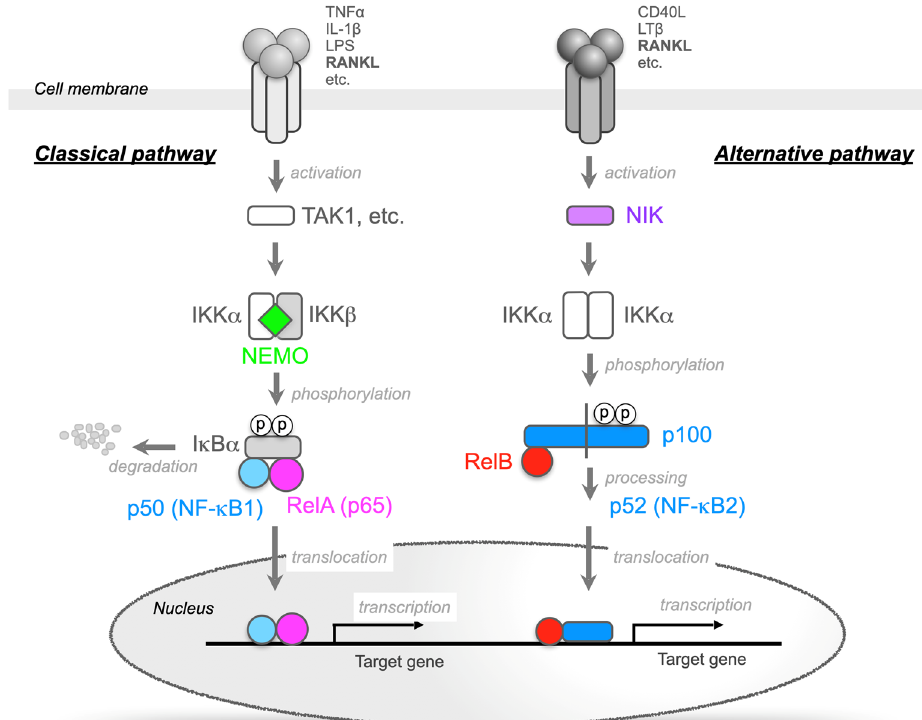
Figure 2. Two different NF- κ B signaling pathways. The classic (canonical) pathway ( left ) is activated by a large number of agonists, such as TNF- α , IL-1, lipopolysaccharide, and T-cell receptors. The activation of this pathway depends on the inhibitor of the κ B (I κ B) kinase (IKK) complex (IKK α / β and NEMO), which phosphorylates I κ B α (Ser32, 36) to induce rapid degradation. This pathway is essential for immune responses, inflammation, tumorigenesis, and cell survival. The alternative (noncanonical) pathway ( right ) is activated by a limited number of agonists, which are involved in secondary lymphoid organogenesis. This pathway requires NF- κ B-inducing kinase (NIK) and IKK α . These kinases induce the slow processing of p100 to generate p52, resulting in the dimerization and activation of the p52/RelB heterodimer. The activation of NF- κ B signaling stimulates osteoclastic bone resorption and suppresses bone formation.